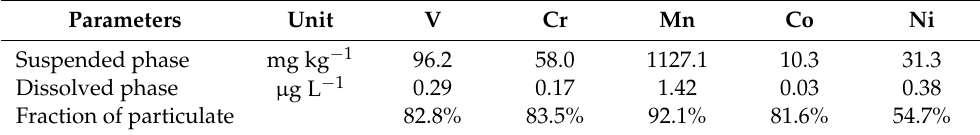
Table 4. Fraction of particulate PTEs’ transportation in the Jiulongjiang River.